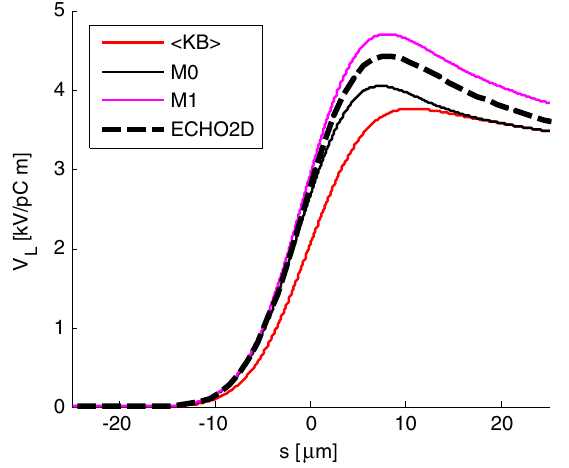
FIG. 7. Short-range longitudinal wake potentials were calcu- ¼ 5 (cid:2) m using different models (solid lated for a bunch of (cid:1) z lines): h KB i (red), M0 (black), M1 (magenta), and ECHO2D code (dashed line).